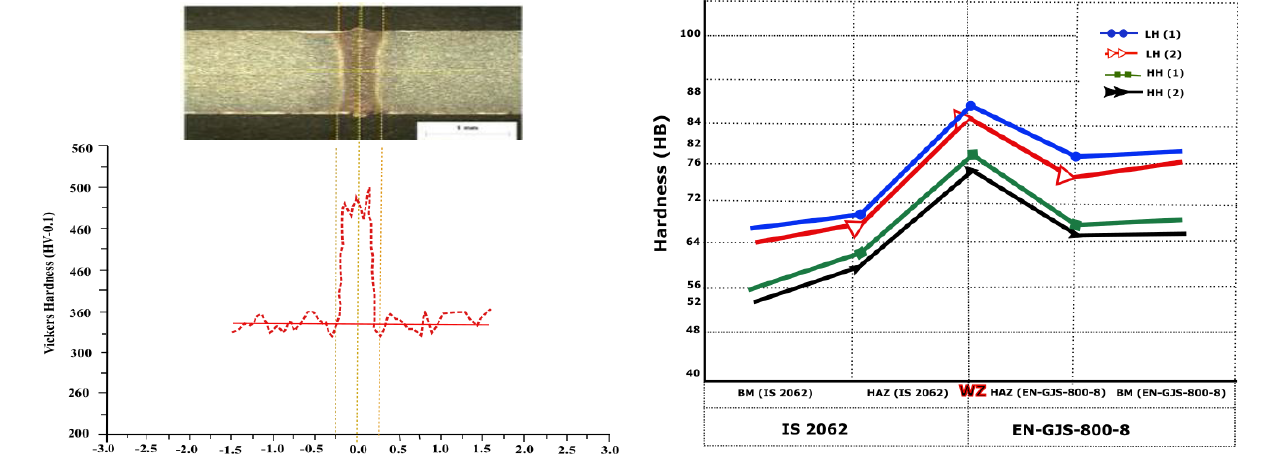
Figure 11: Hardness profile of sample: P2 / S150. Reprinted with permission from Alves et al. , // Journal of Materials Processing Tech.